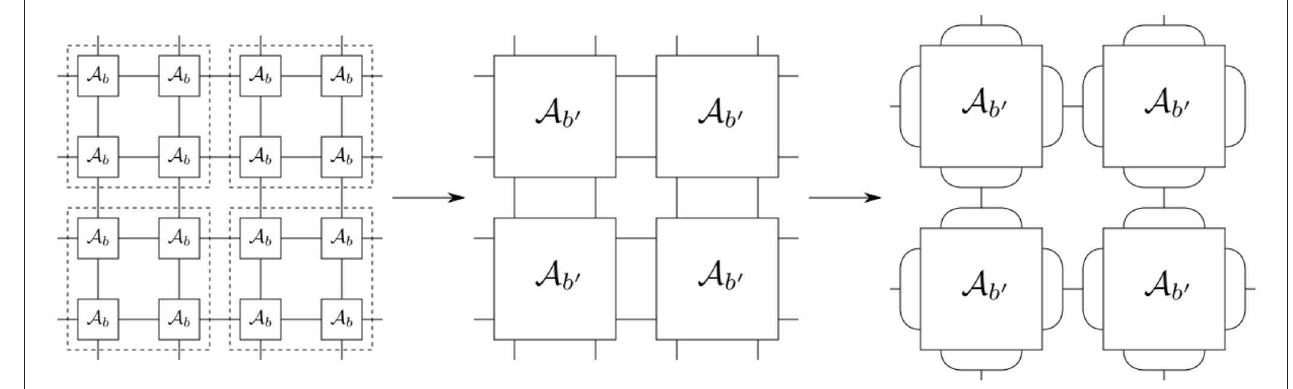
FIGURE 5 | The basic steps of coarse graining: blocking of amplitudes, summing over fine degrees of freedom and introduction of embedding maps to define an effective amplitude for the original Hilbert space H b .